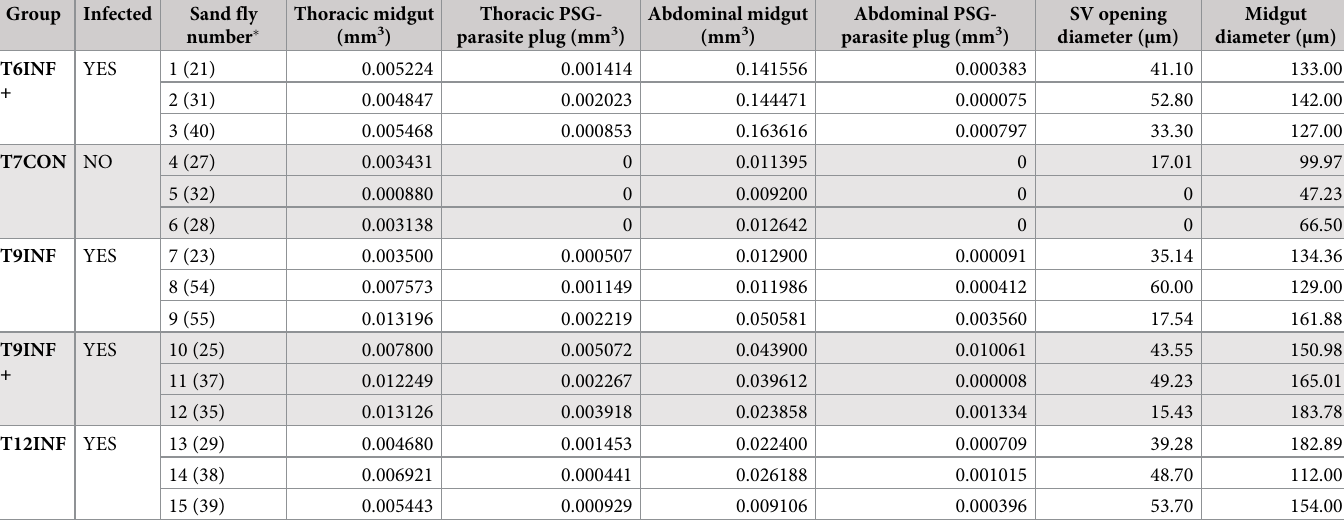
Table 1. Measurements from micro-CT micrographs of three individual sand flies in each of the five experimental (infected) or control (uninfected) groups show- ing thoracic and abdominal midgut and PSG-parasite plug volumes and diameters of the stomodeal valve (SV) opening and of the anterior midgut just posterior to the SV (see Fig 3D for example). T7CON flies were 7 days after a non-infected blood meal. T9INF and T12INF flies were 9 and 12 days, respectively, after an infected blood meal. T6INF+ and T9INF+ flies were 6 and 9 days, respectively after an infected blood meal and 1 and 4 days, respectively, after a second, non-infected blood meal. Group